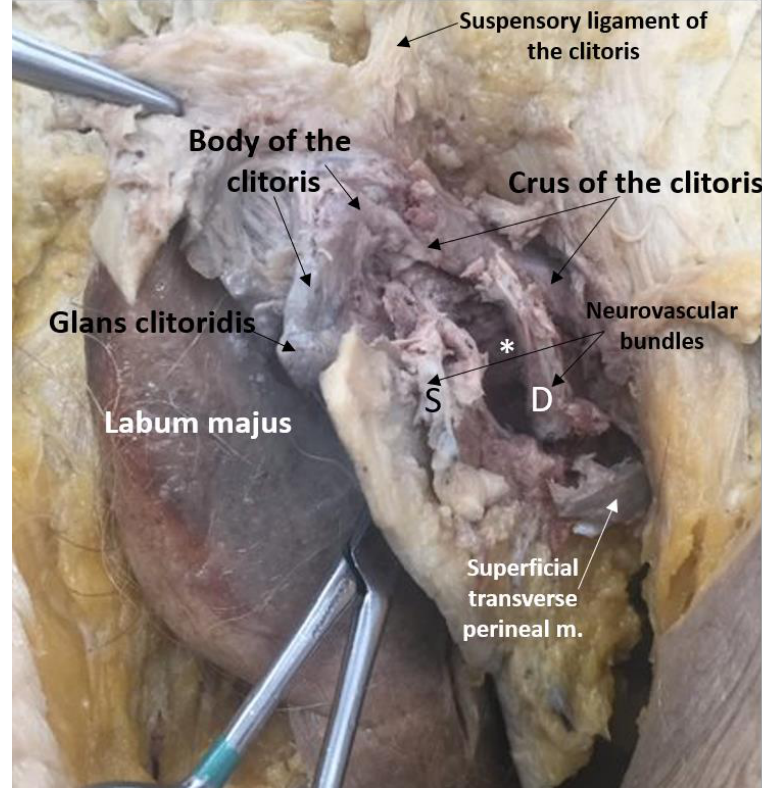
Figure 4. Female perineum dissected to reveal all perineal structures accessed by continuing a mediolateral episiotomy incision. The neurovascular bundles contain branches of the superficial (S) and deep (D) perineal nerves and the internal pudendal artery. *Bulb of the vestibule overlain by the bulbospongiosus muscle.